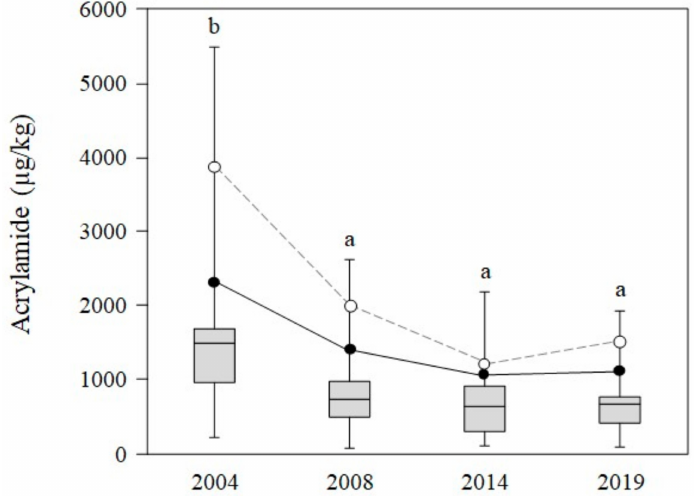
Figure 4. Temporal patterns for acrylamide content ( µ g / kg) in Spanish potato crisps sampled from 2004 to 2019. represents 90th percentile, represents 95th